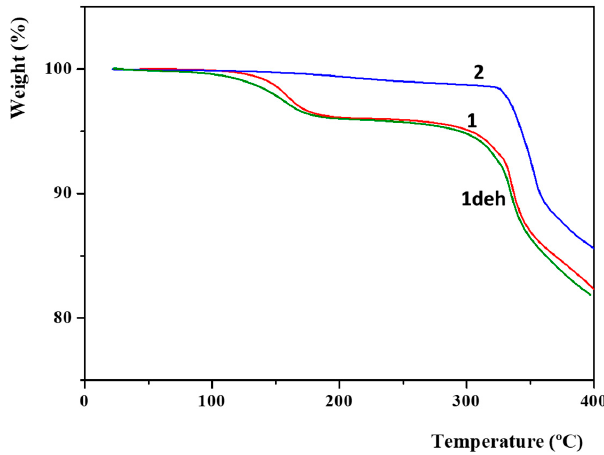
Figure 2. Thermal analysis for Compounds 1 , 2 , and 1deh after rehydration.